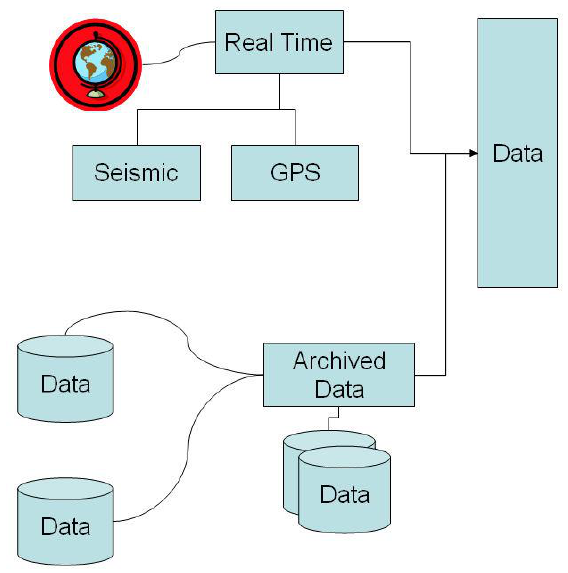
Figure 5. Current and future data streaming to the system Service-oriented architecture of the application allows its components to be used by other applications and users over the Internet. Since reusability of components was provided, it minimized the need for new coding. Its infrastructure is ready